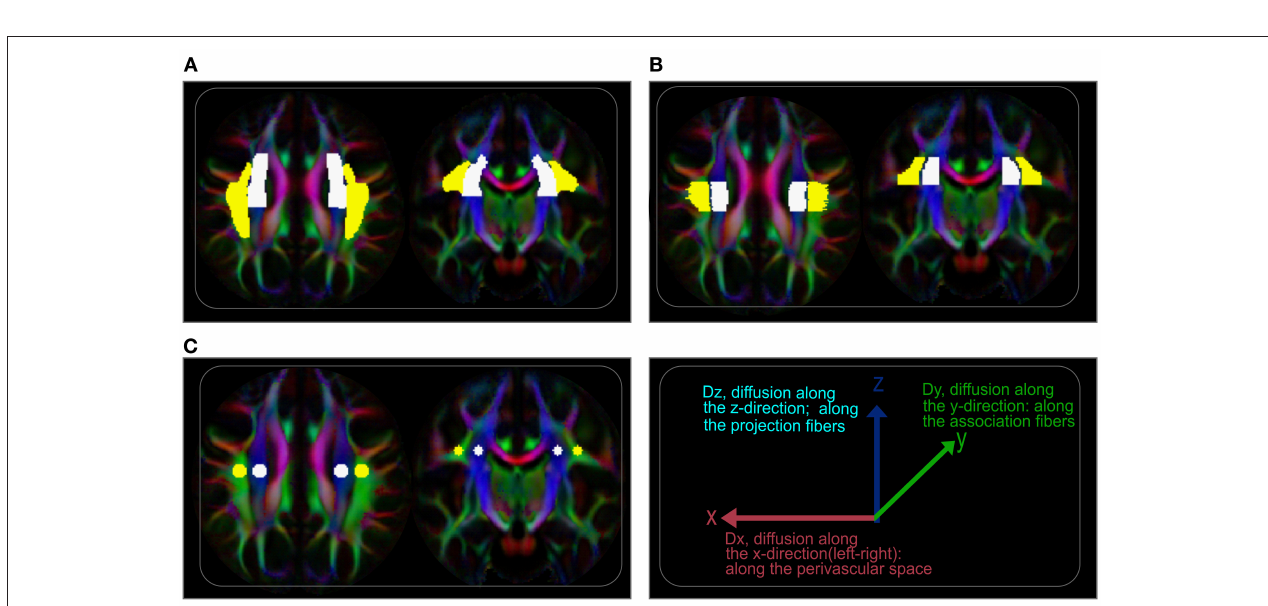
FIGURE 2 | Regions of interest (ROIs) for ALPS index evaluation. (A) Axial (left) and coronal (right) visualization of the ROIs showing labels of the projection and association fiber areas defined by the labels of JHU-ICBM DTI-81 atlas. On the atlas-based approach (unguided), these labels were used to extract ALPS values from coregistered tensor maps. (B) Regions of the projection and association fiber areas along the periventricular space manually delineated, guided by diffusion maps (color-coded FA). (C) 5-mm-diameter spherical regions placed on the projection and association fiber areas with the centers on the reference slice.